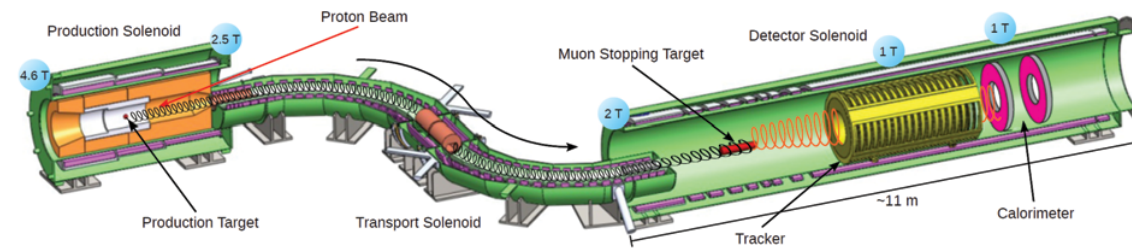
Figure 4. Layout of the Mu2e experiment.